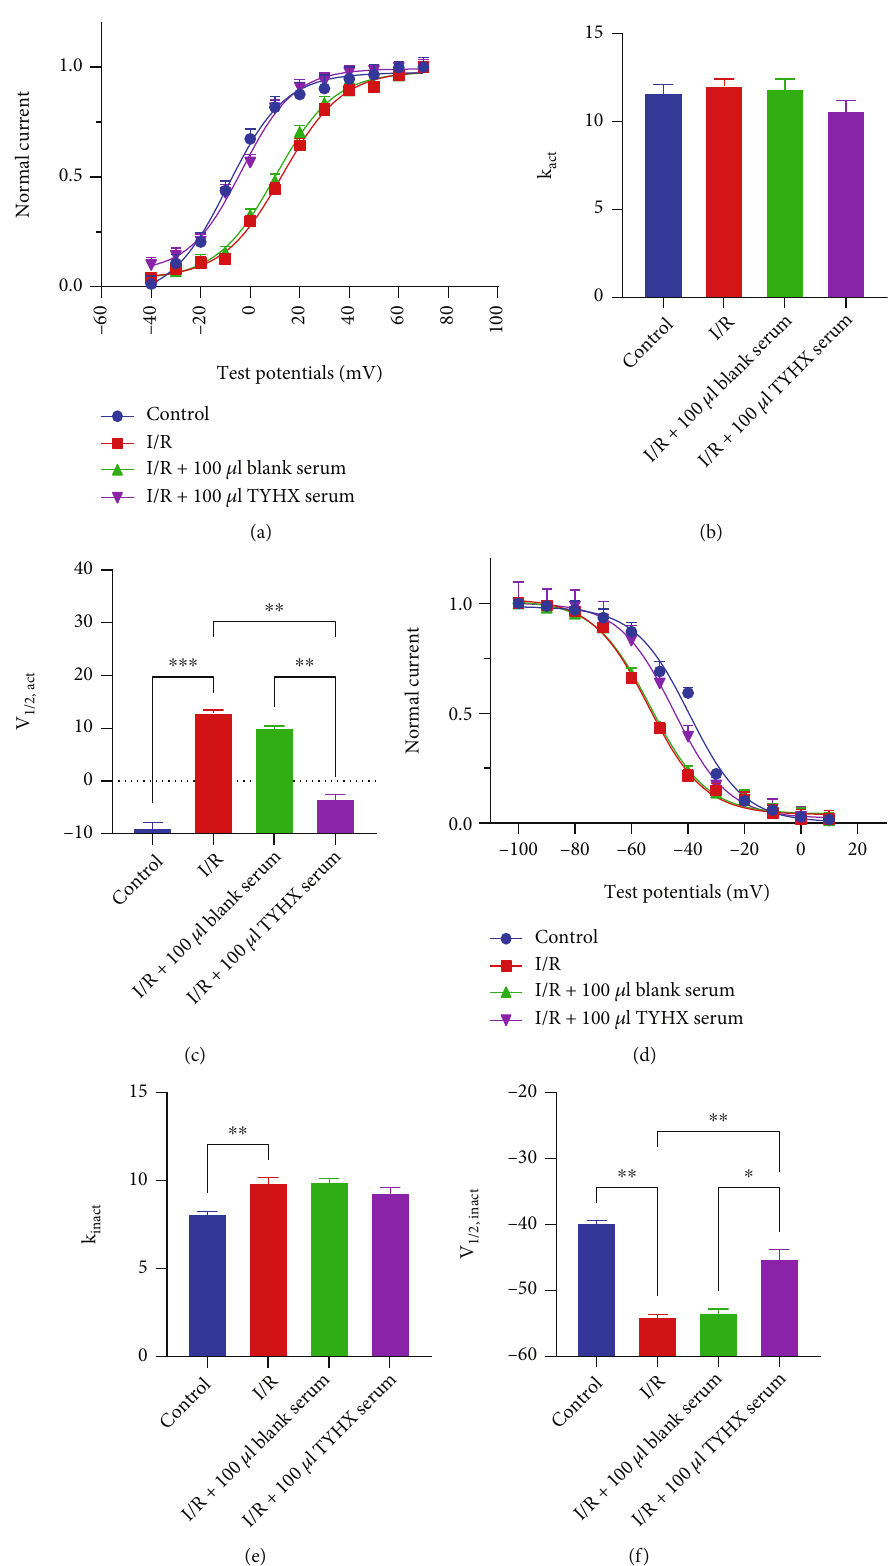
Figure 3: The e ff ect of TYHX on steady-state activation and inactivation of I V fi cantly rose in the I/R group, and TYHX reversed it. (c) k value of SSA. k value was no di ff erent in the three V 1/2,act of SSA. 1/2,act signi groups. (d) The e ff ect of TYHX on steady-state inactivation of I di ff erence in the three groups. ∗ p < 0 : 05 , ∗∗ p < 0 : 01 , and ∗∗∗ p < 0 : 001